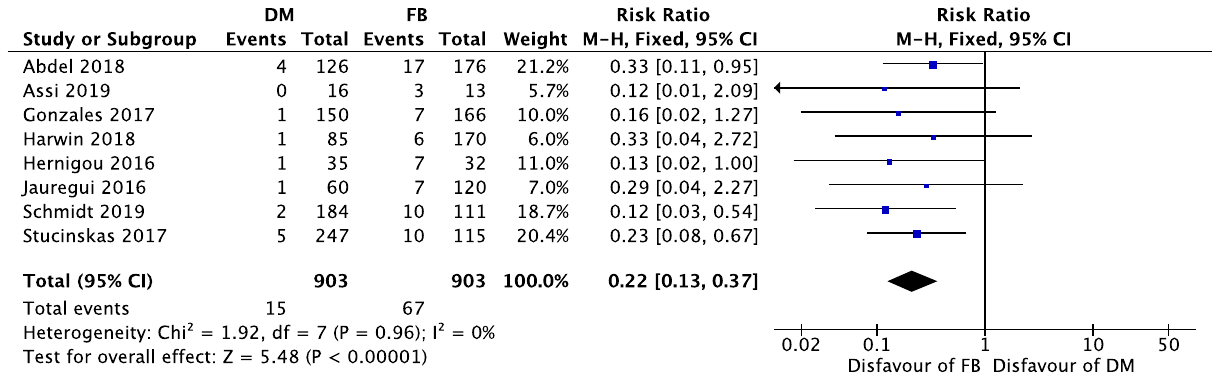
Figure 4. Forest plot for dislocation rate.